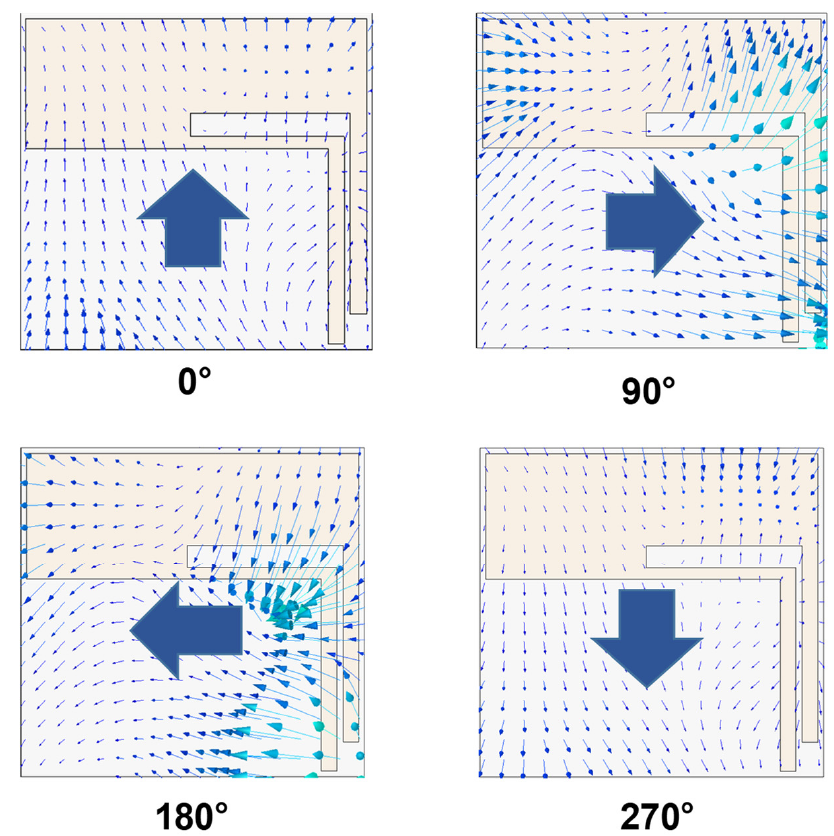
Figure 3. Electric field strength distribution in the frontal direction (9.0 GHz). The circularly polarized waves radiate in the +z direction, in which the radio waves propagate.